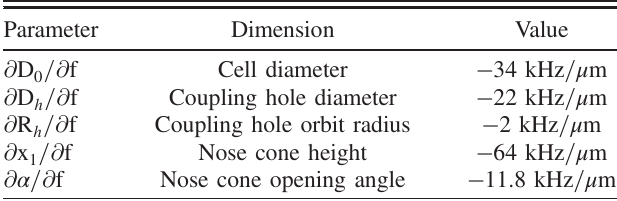
TABLE IV. Frequency sensitivity of the NHS cell to the critical dimensions, as shown in Fig.